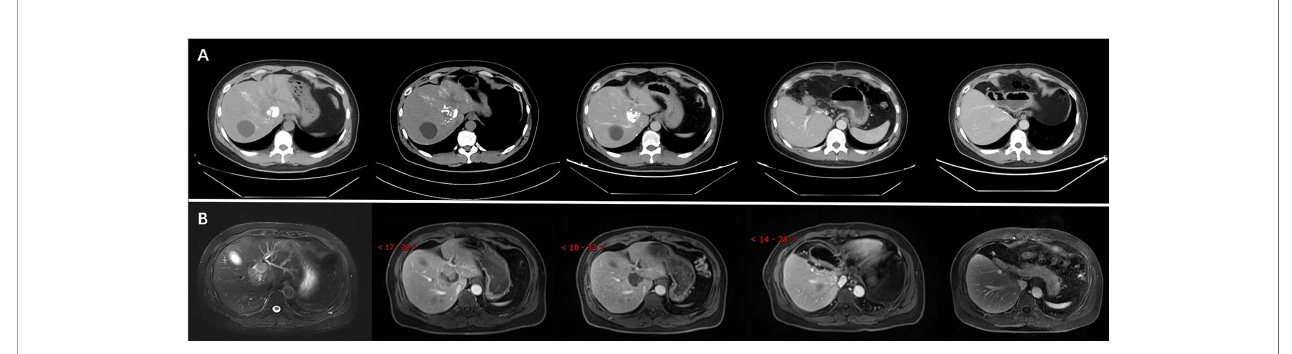
FIGURE 3 | The CT (A) and MRI (B) revealed reduction of tumour size after TACE and con fi rmation of complete response (CR)